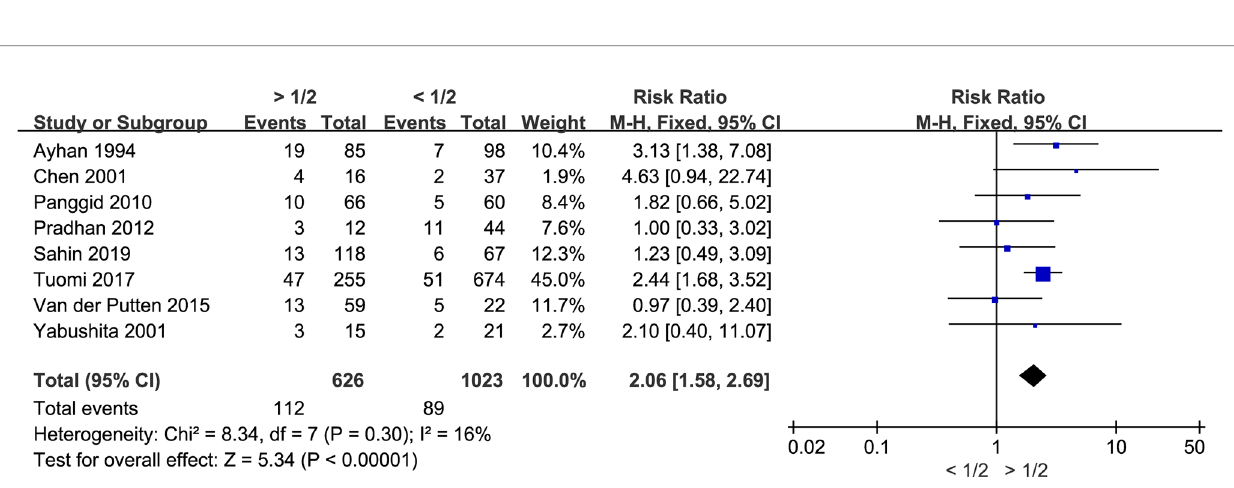
FIGURE 3 | Meta-analysis of the association between myometrial invasion and recurrence in patients with endometrial cancer.